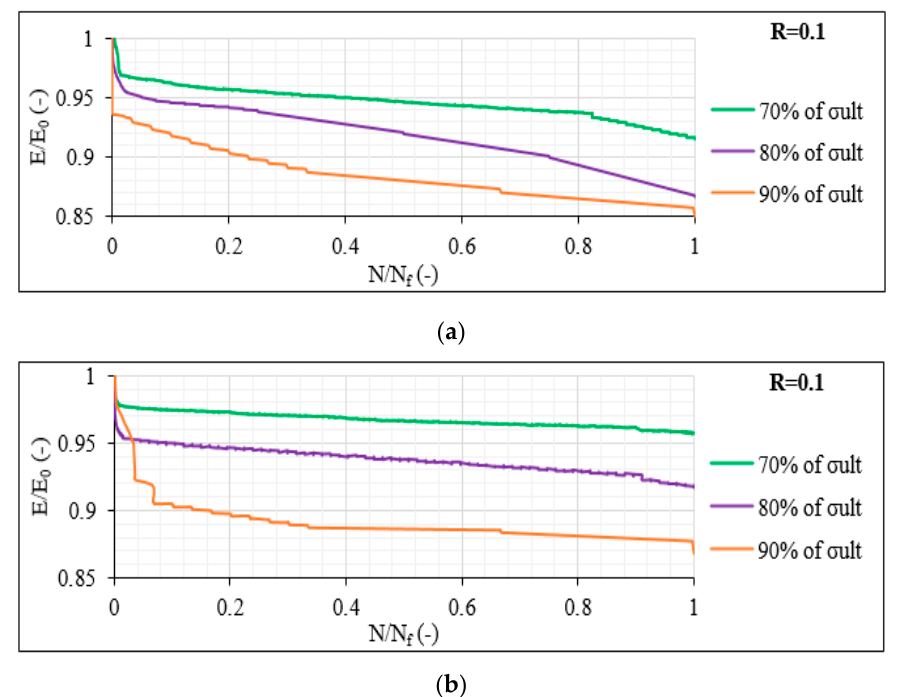
Figure 21. Stiffness degradation versus the normalised fatigue life in ( a ) [0°/30°] 2s and ( b ) [0°/60°] 2s laminates for R = 0.1.